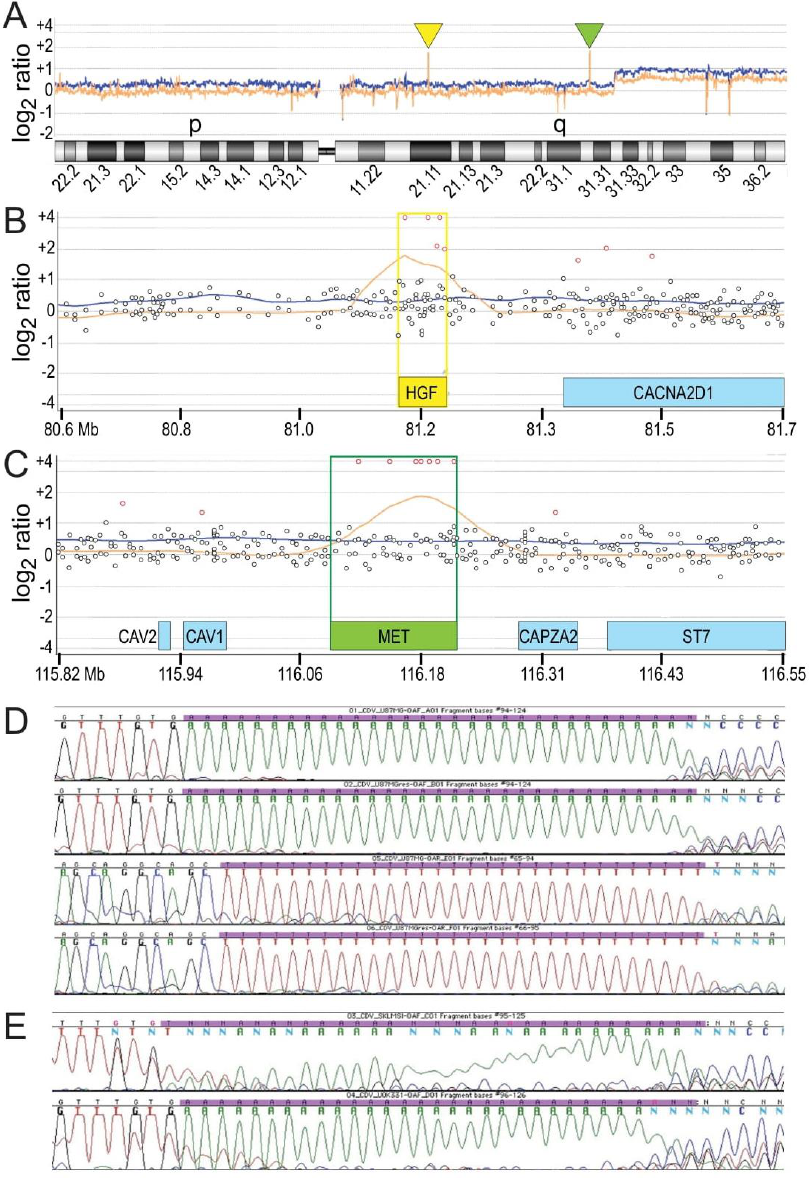
Figure 5. HGF and MET gene amplification and HGF gene promoter DATE region analysis. ( A ) View of human chromosome 7 CGH microarray analysis results showing moving averages of probe intensity for U87 MG (blue line) or U87 MG/HNR cells (tan line). Inverted triangles indicate the positions of HGF (yellow) and MET (green) genes. Horizontal lines above and below the center indicate probe intensities corresponding to whole copy number changes. ( B , C ) Zoomed view of chromosome 7 regions encoding the genes for HGF (( B ), yellow box) and MET (( C ), green box). Other nearby gene loci are indicated by blue boxes. As in ( A ), moving averages of probe intensities for U87 MG (blue) or U87 MG/HNR cells (tan) are shown. Circles indicate individual probes with intensity values corresponding to gain or loss of less than one gene copy (black) or greater than one gene copy (red). ( D ) DNA sequencing chromatogram encompassing the DATE region in the HGF gene promoter. Coding strand sequence (green) for U87 MG DNA (top panel) and U87 MG/HNR DNA (second panel from the top) and non-coding strand sequences for each cell line (third and fourth panels from the top, respectively) shown normal DATE region length in both U87 MG and U87 MG/HNR cells. ( E ) Control samples for DATE sequence truncation (coding strands only) obtained from the leiomyosarcoma cell line SK-LMS-1 ( top ) and for normal DATE region length obtained from the clear cell renal cell carcinoma cell line UOK331 ( bottom